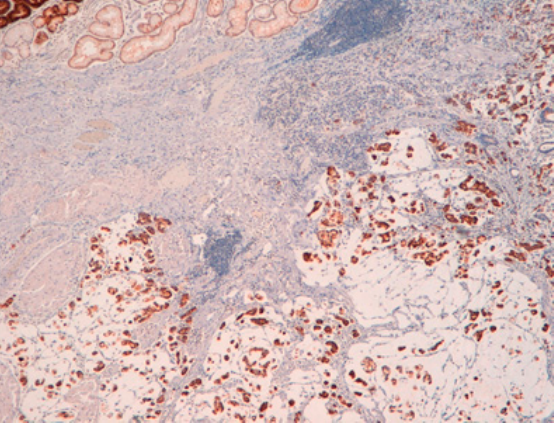
Figure 1. Pen A EGC showing infiltration of the submucosa layers in nodular masses.